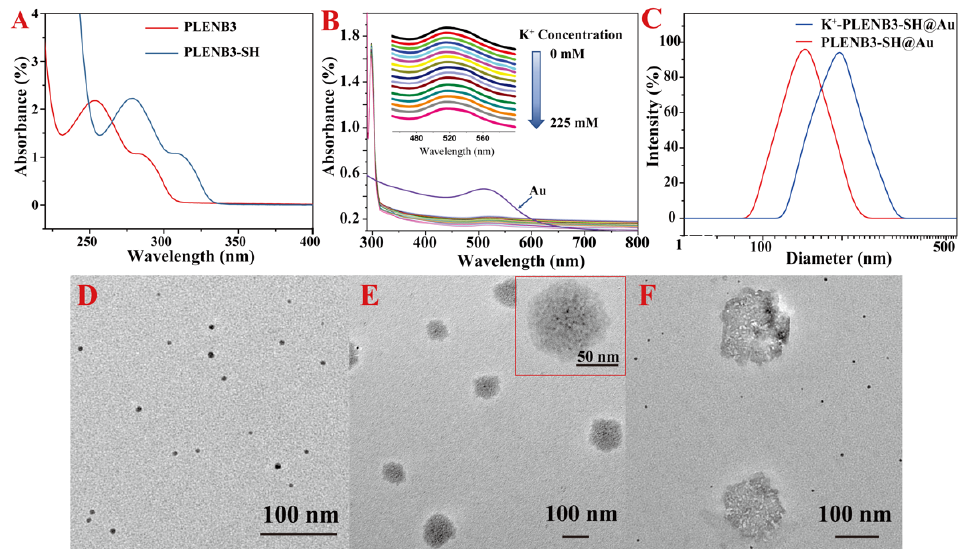
Figure 6. ( A ) UV − vis spectra of PLENB3 and PLENB3-SH; ( B ) UV − vis spectra of Au NPs, PLENB3- SH@Au, and K + -PLENB3-SH@Au with different K + concentration; ( C ) DLS of PLENB3-SH@Au and K + -PLENB3-SH@Au; ( D ) TEM image of AuNPs; ( E ) TEM images of PLENB3-SH@Au, and the inset